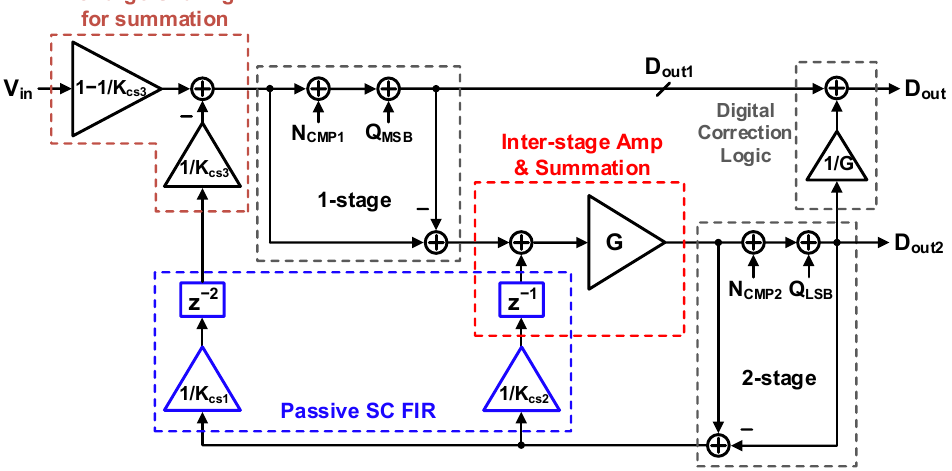
Figure 2. Detailed block diagram of proposed ADC architecture.